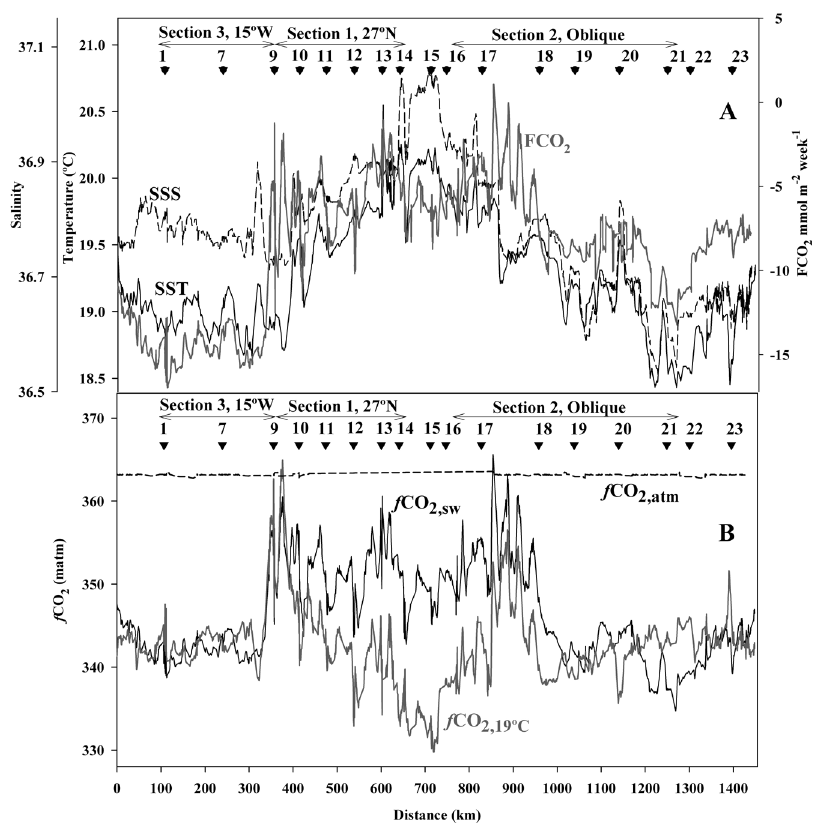
Fig . 2. – Distribution of A) sea surface temperature (SST), salinity (SSS) and CO in the atmosphere ( f CO